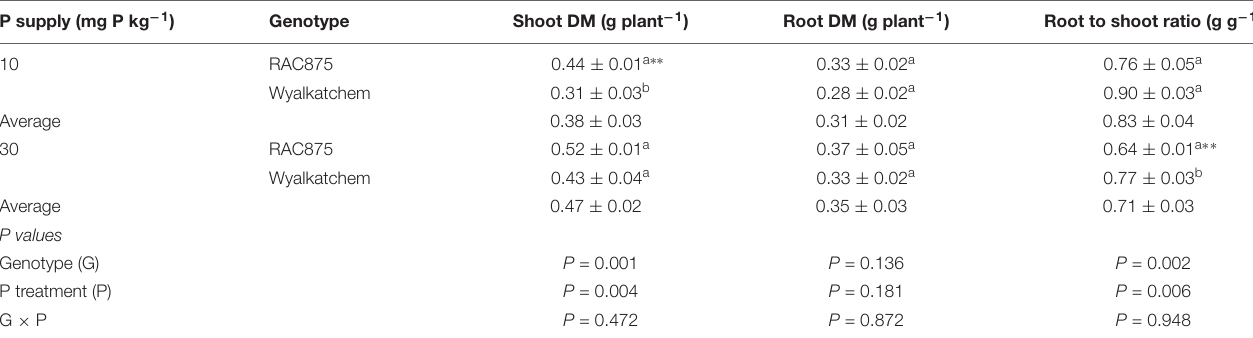
TABLE 1 | Shoot DM, root DM, root to shoot ratio, and rhizosheath size of two wheat genotypes grown under the growth room conditions at 28